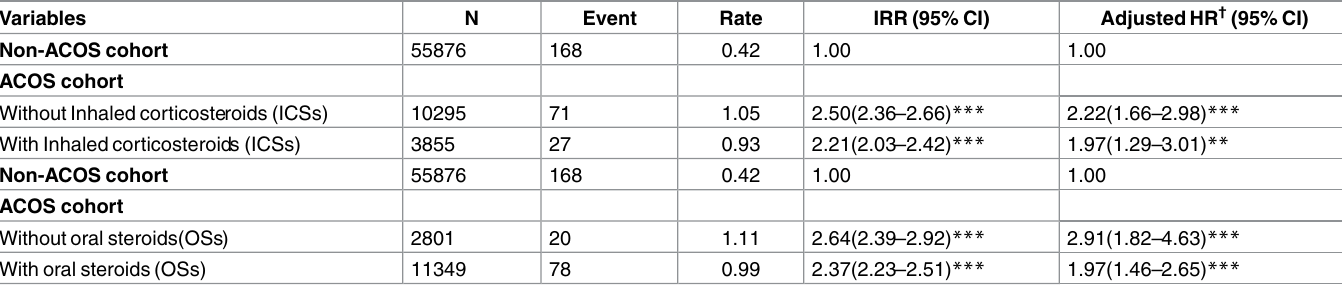
Table 4. Adjustedhazard ratioof pulmonary embolismfound in the follow-upperiodassociated withACOS and prescriptions of ICSs and OSs. Variables